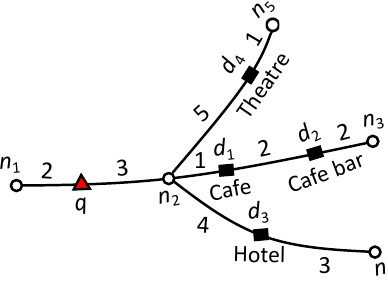
Figure 4. Upper bound score